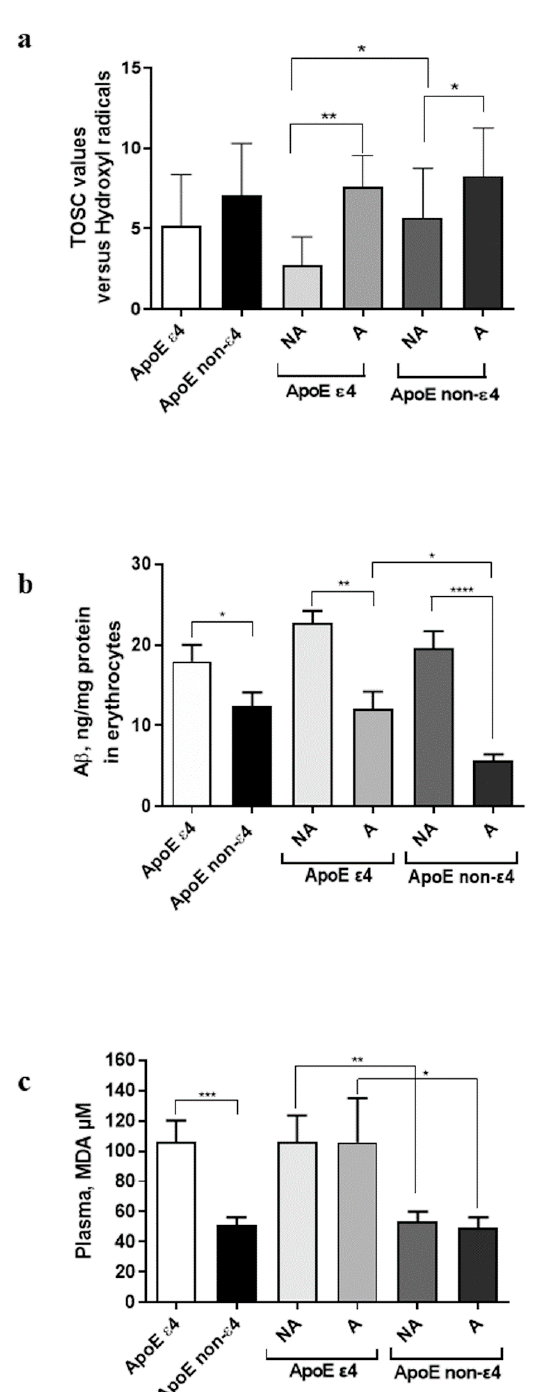
Figure 1. Plasma AOC levels, erythrocyte A β accumulation, and plasma lipid peroxidation amount in active and non-active subjects depending on ApoE genotype. ( a ) Plasma AOC depends on ApoE genotypeandincreaseswithphysicalactivity.HighTOSCvaluesareassociatedwithelevatedantioxidant capacity. ( b ) A β accumulation in erythrocytes is influenced by ApoE genotype and decreases with physical activity. ( c ) Lipid peroxidation is higher in ApoE ε 4 carriers and is not modulated by physical activity. The data are presented as the mean value ± S.D. and are representative of three independent experiments ( n = 3). Di ff erence among groups were assessed by One-way ANOVA. P -values were adjusted with Sidak’s multiple comparison test: * P < 0.05, ** P < 0.01, *** P < 0.001, **** P < 0.0001 between the indicated